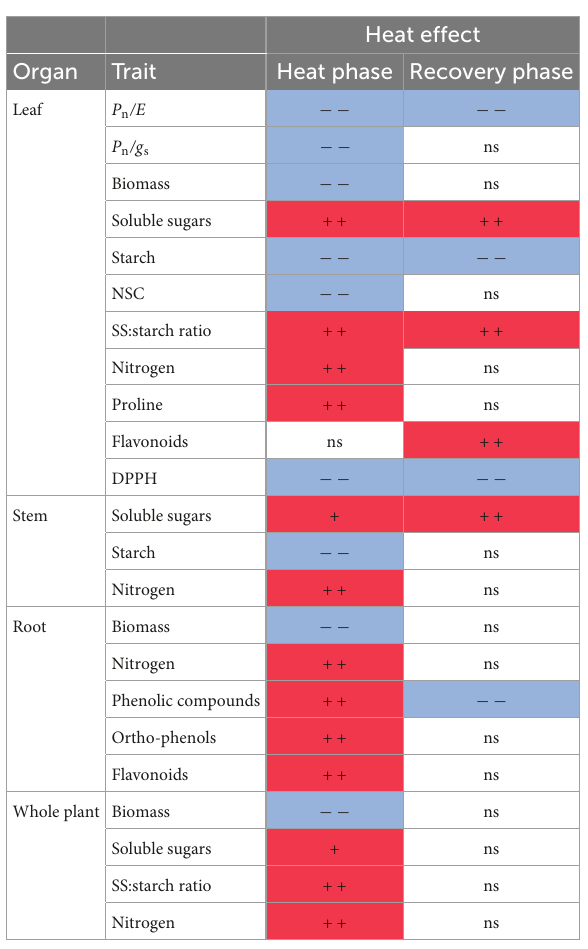
( Figure 5 ). This correlation changed from negative under control conditions to positive under heat stress conditions